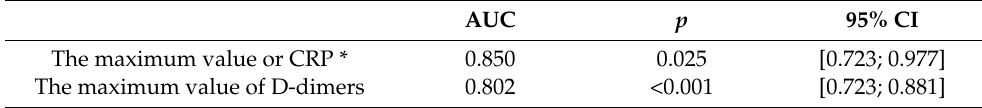
Table 2. Biological markers proven as good predictors of death in ROC curve